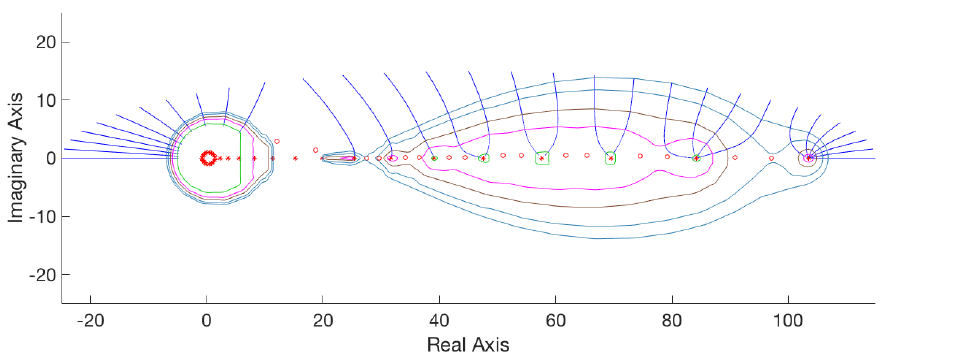
Figure 4. Pseudospectra computation for the Frank matrix of order 32 and (cid:101) = 0.001, 0.005, 0.01, 0.02, 0.03. Additional points selected between the endpoints of the initial sequences are denoted by red circles, while eigenvalues are denoted by red stars. Table 2. Number of iterations for different numbers of initial points ( (cid:101) 0 = 0.001). # of Initial Points 10 15 30 Iterations (initial points) 11,206 18,455 35,159 Iterations (additional points) 16,116 14,872 11,883 Iterations (total) 27,322 33,327 47,042 Table 3. Relative approximation errors for Perron root and other eigenvalues of the Frank matrix of order 32. Mean Rel. Error Mean Rel. Error # of Mean Rel. Error (Intermediate Iterations (Perron Root)